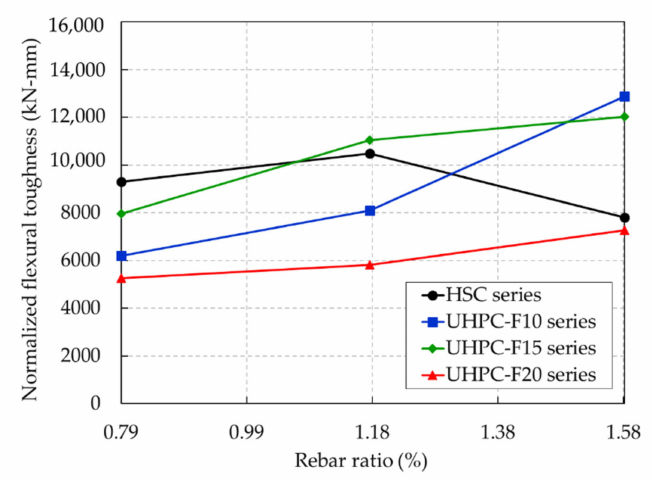
Figure 20. Normalized toughnesses of the UHPC and HSC